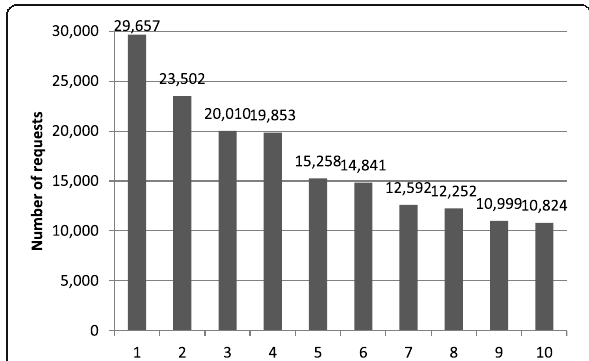
Fig. 10 Top ten most common preference settings (without